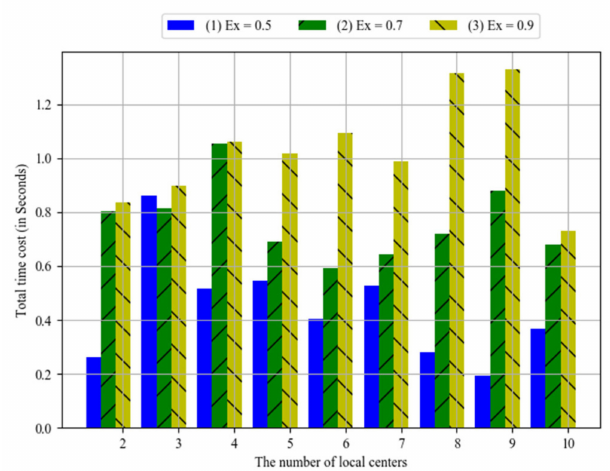
Figure 15. The impact of system bus communication.